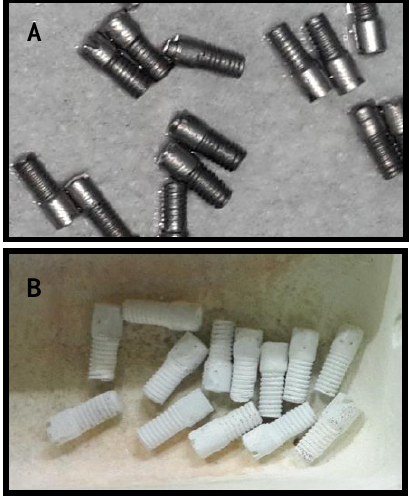
Figure 1: (A) Uncoated implant screws. (B) Coated implant screws with CaCO 3